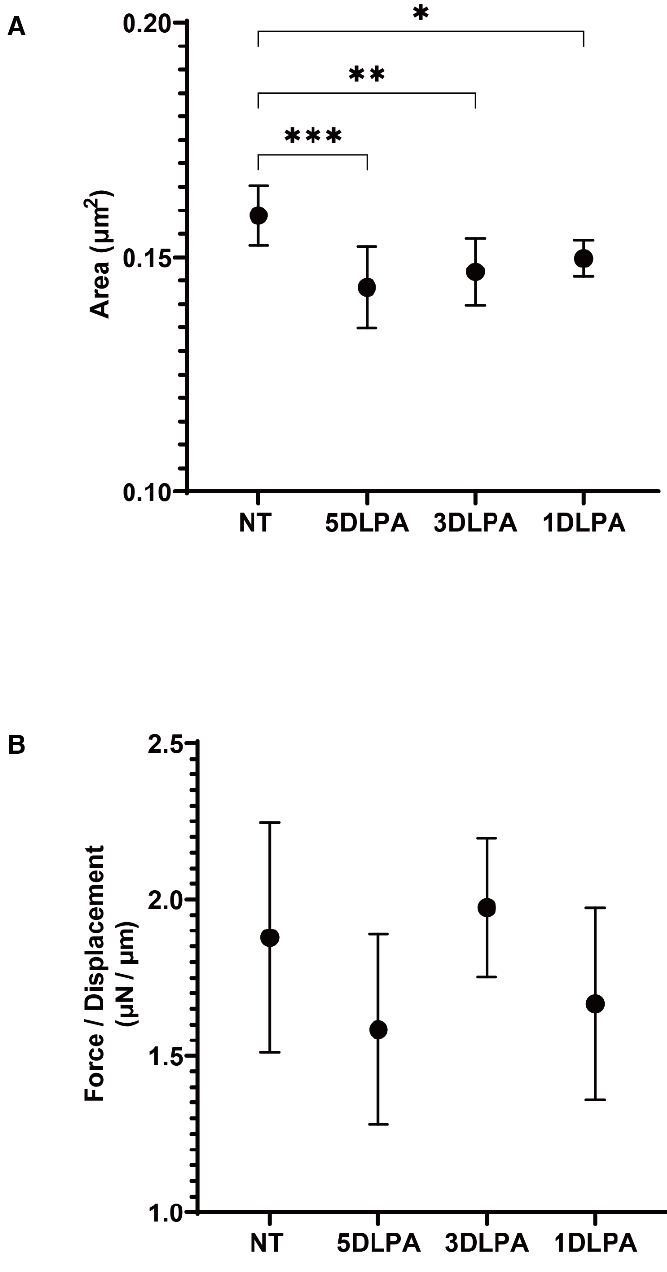
Figure 1. Effects of the exposure of different concentrations of LPA on the physical properties, size and stiffness of 3D HTM spheroids. During the 6-day culture of the 3D HTM spheroids, 200 nM LPA was exposed during Day 1 through 6 (5D LPA), Day 3 through 6 (3D LPA) or Day 5 through 6 (1D LPA). The mean sizes ( A ) and stiffness ( B ) of the HTM 3D spheroids under three different exposure conditions of fixed concentration of LPA (200 nM) were compared with non-treated controls with LPA (NT). Data are presented as the arithmetic mean ± standard error of the mean (SEM). * p < 0.05, ** p < 0.01, *** p < 0.005 (ANOVA followed by Tukey’s multiple comparison test).